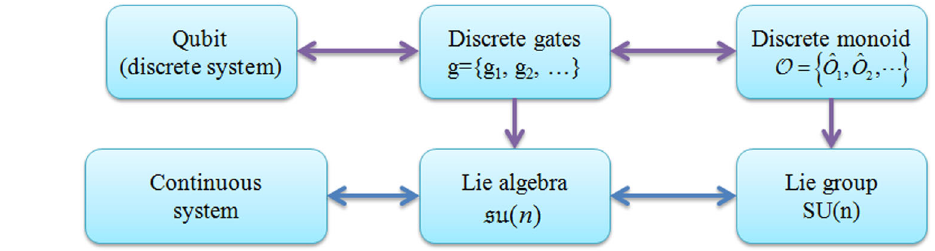
Fig. 6 Schematic diagram for the relation and difference between qubit systems and SU( n )